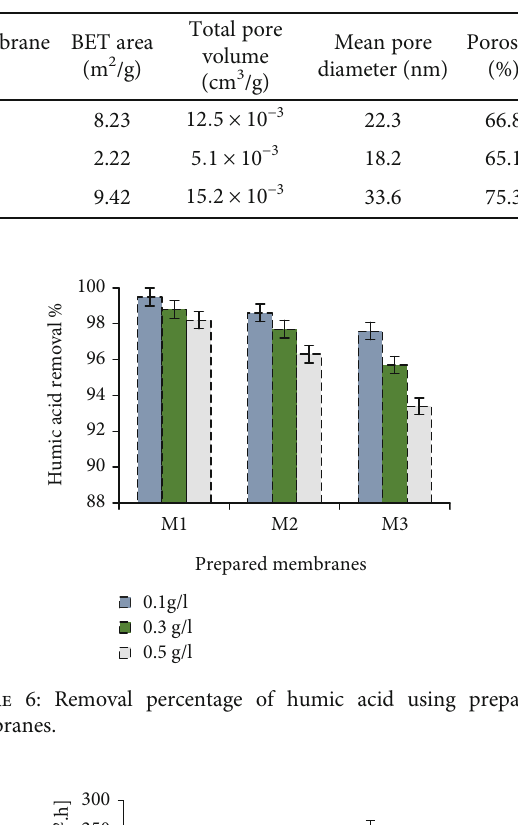
Table 2: Porosity and average pore size distribution for prepared membranes.